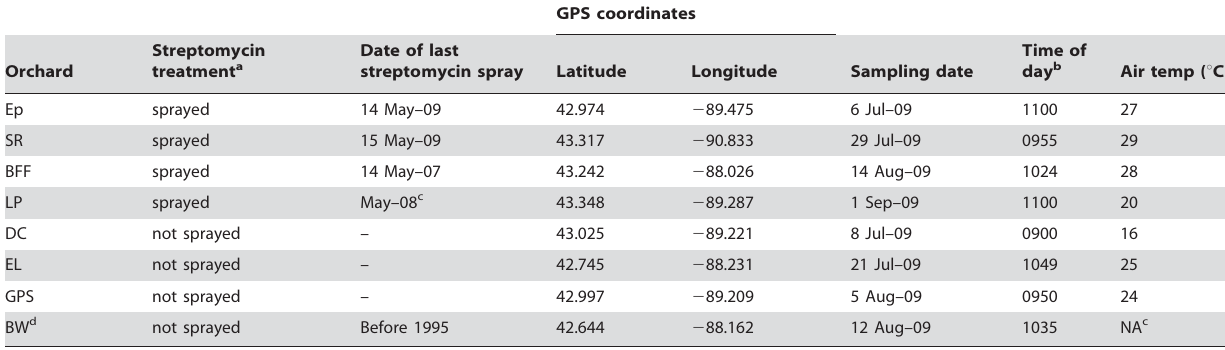
Table 1. Sampling sites and